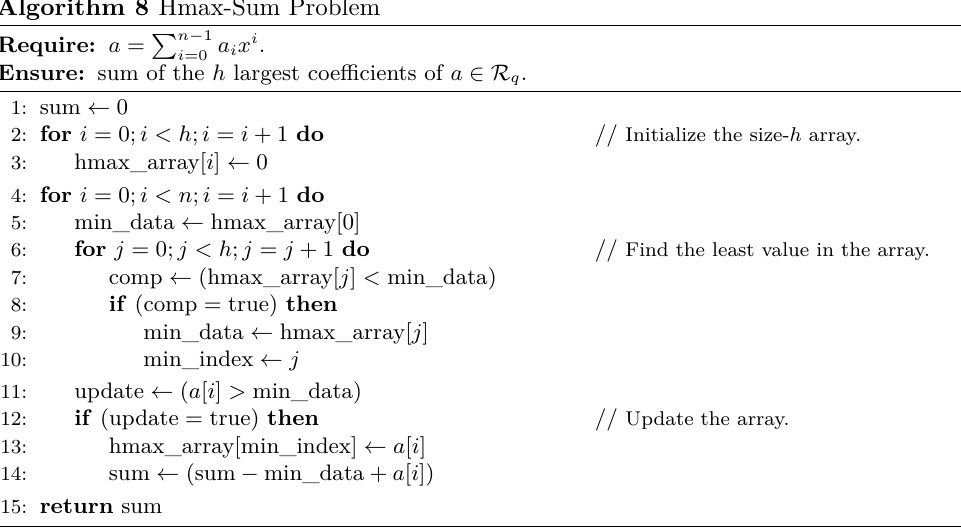
Algorithm 8 Hmax-Sum